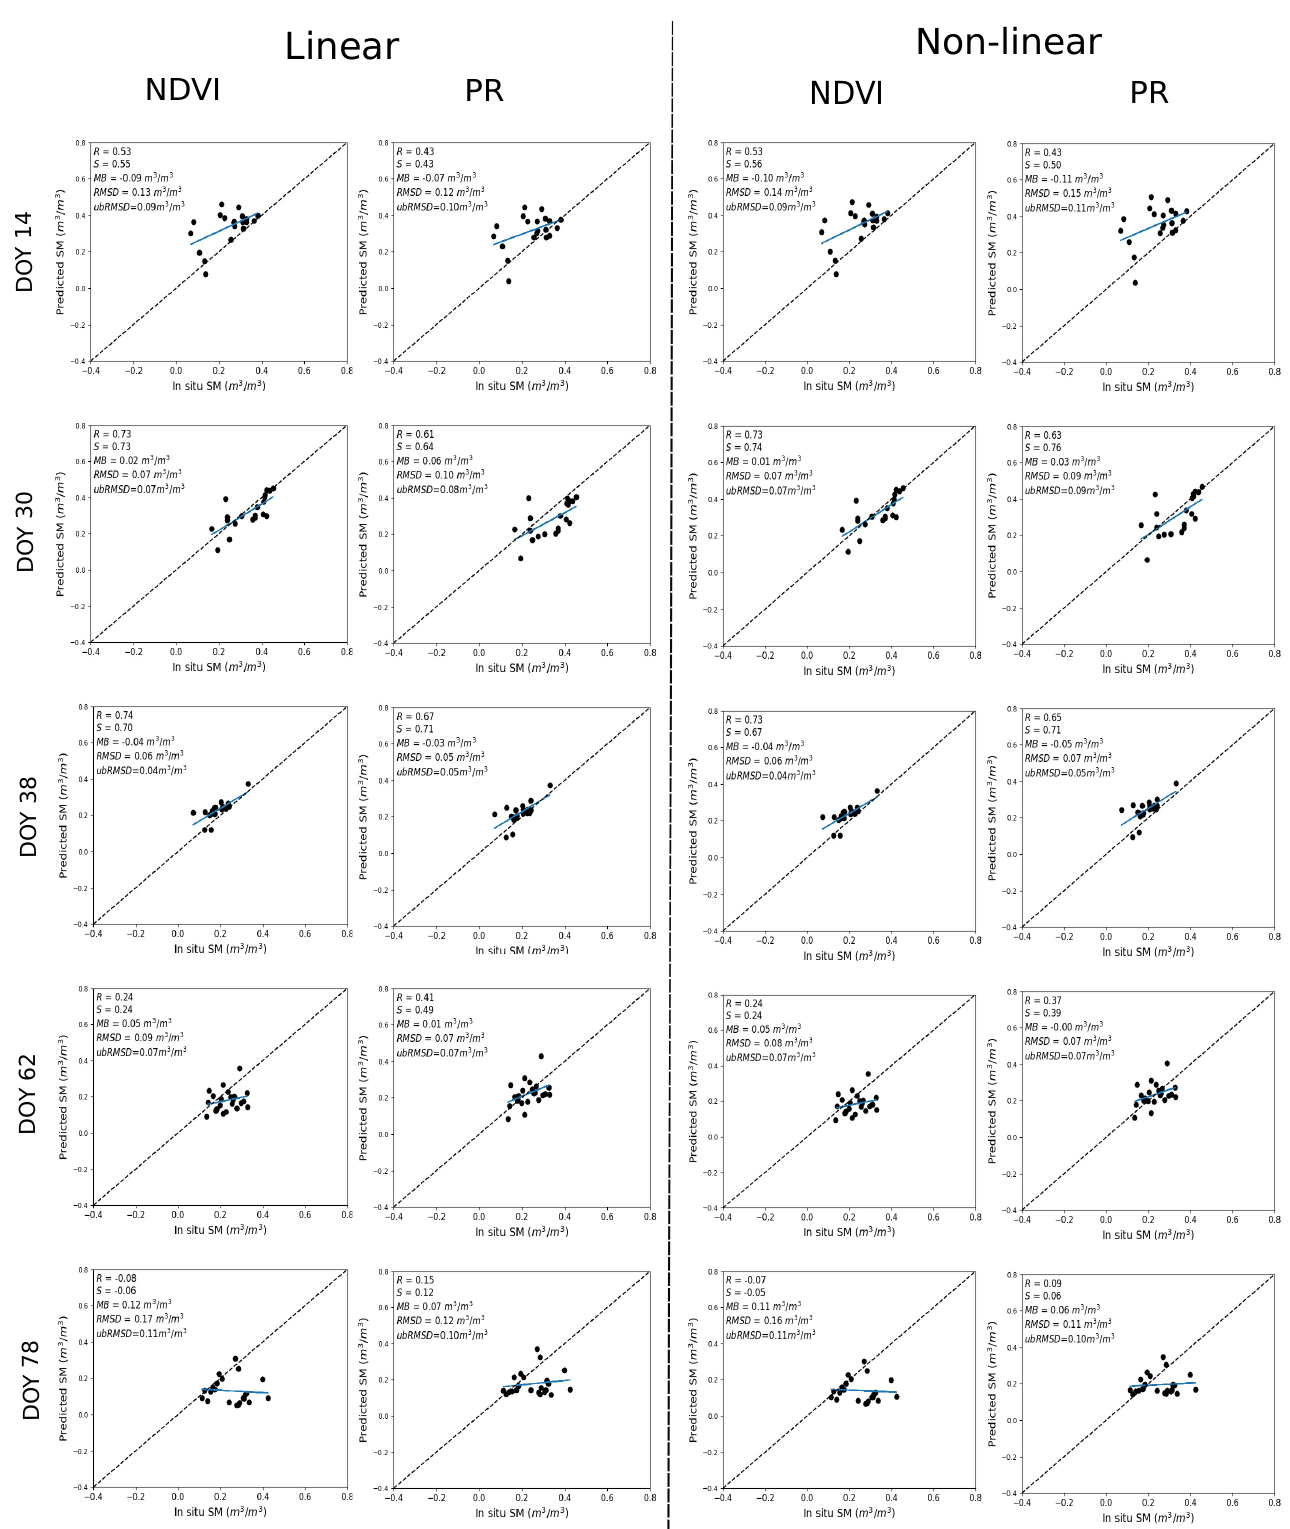
Figure 6. Scatter plot over the R3 irrigated parameter of predicted versus in situ SM, for linear ( left ) and non-linear ( right ) RTM with NDVI and PR as a vegetation descriptor separately where in situ SM data are used for calibration.